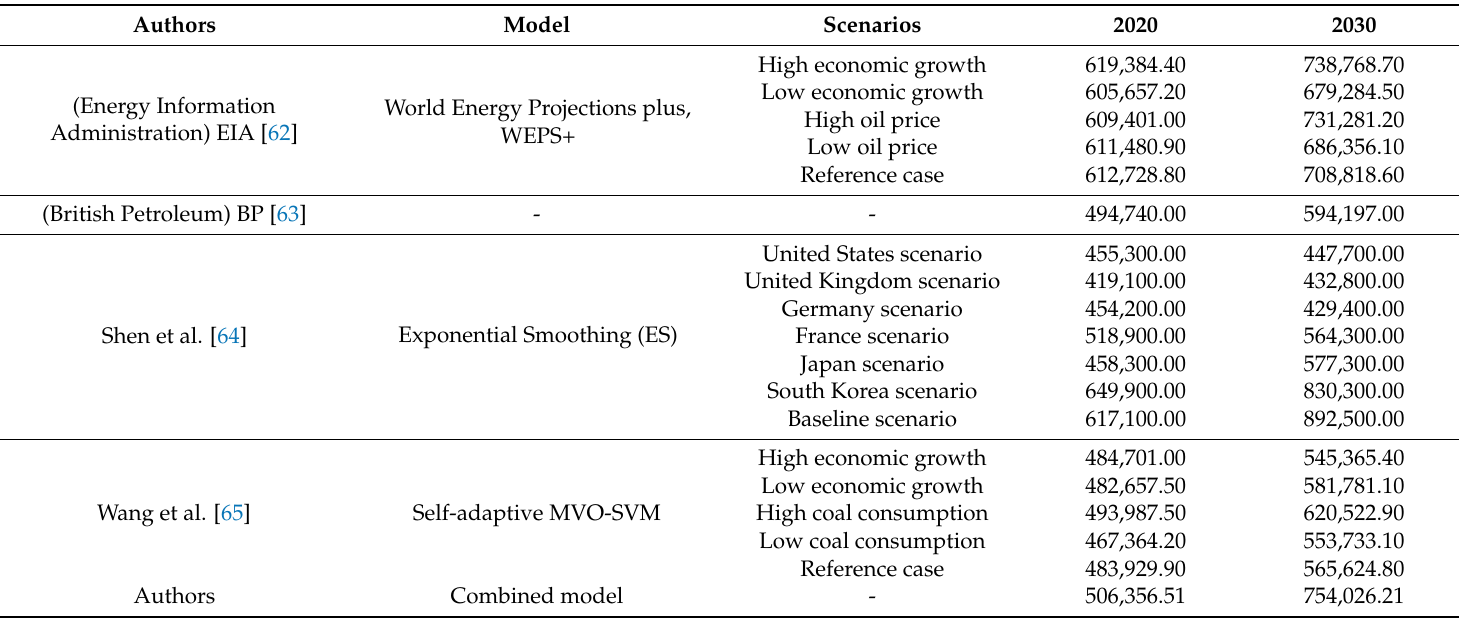
Table A2. Comparison of China’s primary energy consumption predictions between this study and others. (unit: 10 4